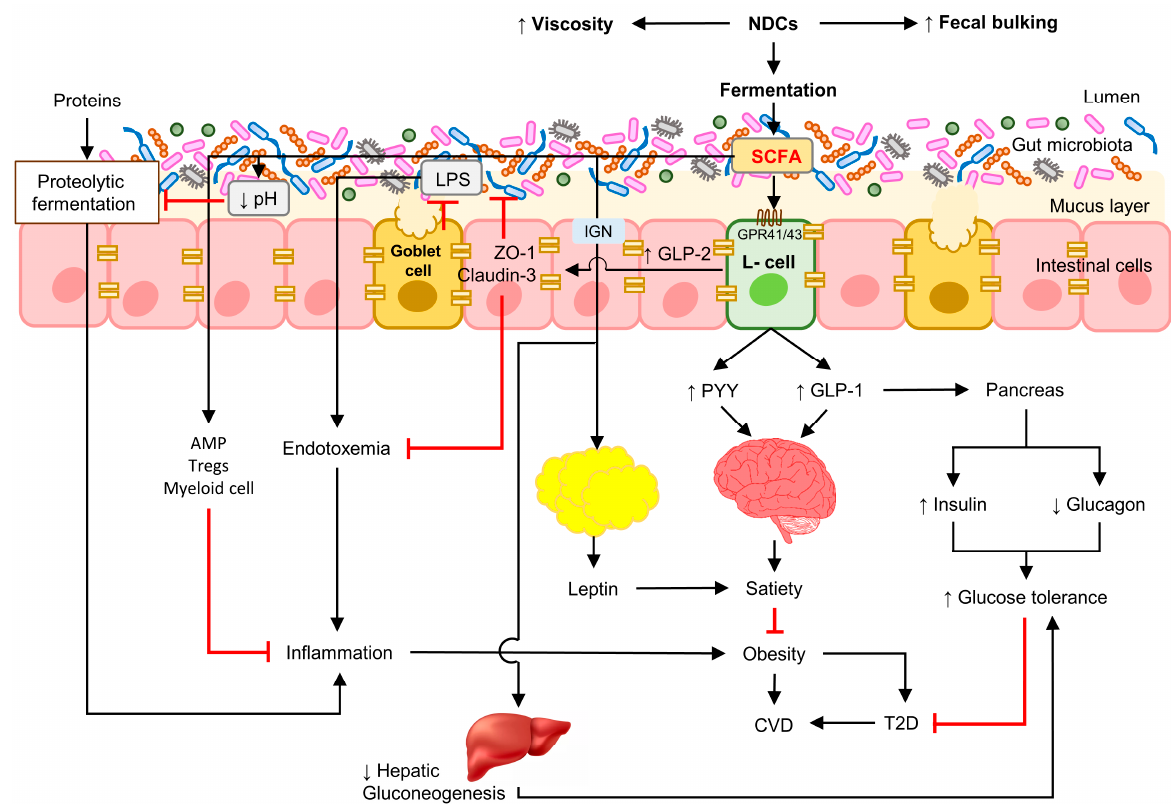
Figure 1. Effect of non-digestible carbohydrates (NDCs) on metabolic diseases (MD) through short-chain fatty acids (SCFA) produced by gut fermentation. AMP, antimicrobial peptides; CVD, cardiovascular disease; GLP, glucagon-like peptide; IGN, intestinal gluconeogenesis; LPS, lipopolysaccharides; PYY, peptide tyrosine tyrosine; SCFAs, short-chain fatty acids; T2D, type 2 diabetes; Tregs, regulatory T-cells; Zo-1, Zonula occludens.